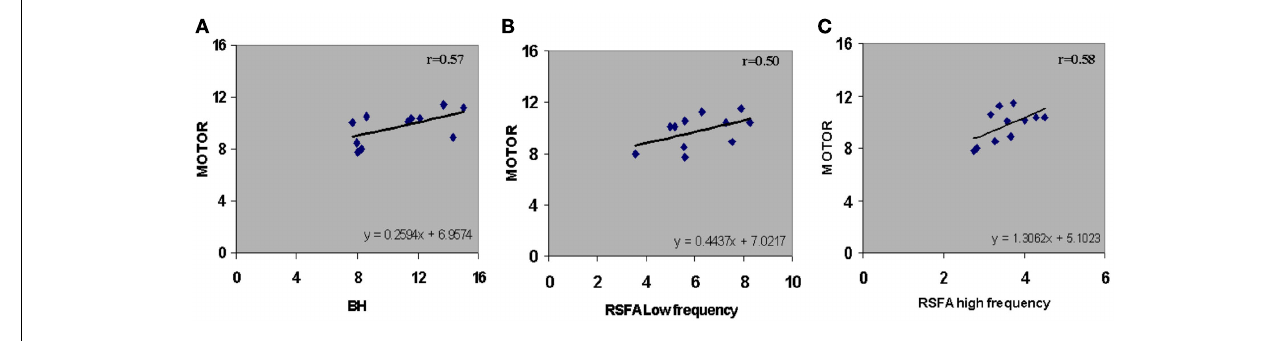
observed from the voxel-averaged BOLD signals at the subject level.The relationships shown in (B) and (C) were subsequently used to predict T-fMRI responses from a second group of subjects scanned at a different